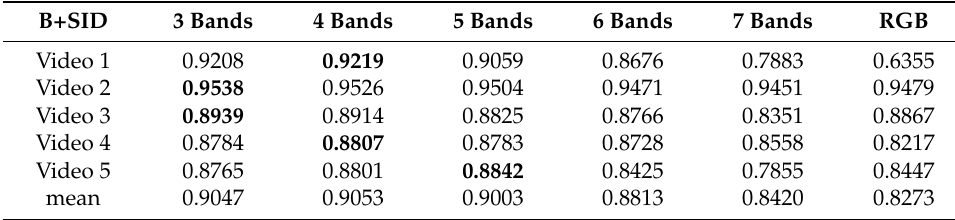
Table 3. Best F-measures with B+SID on five